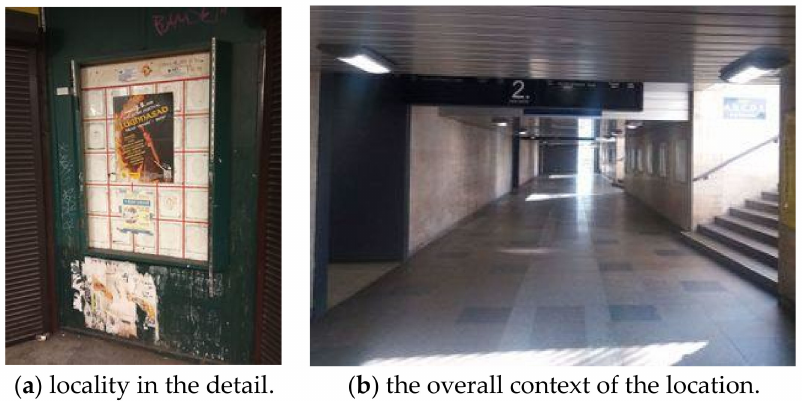
Figure 6. ( a , b ) Underground corridor in the Brno city center close to the main train station (problem- atic location—built-up